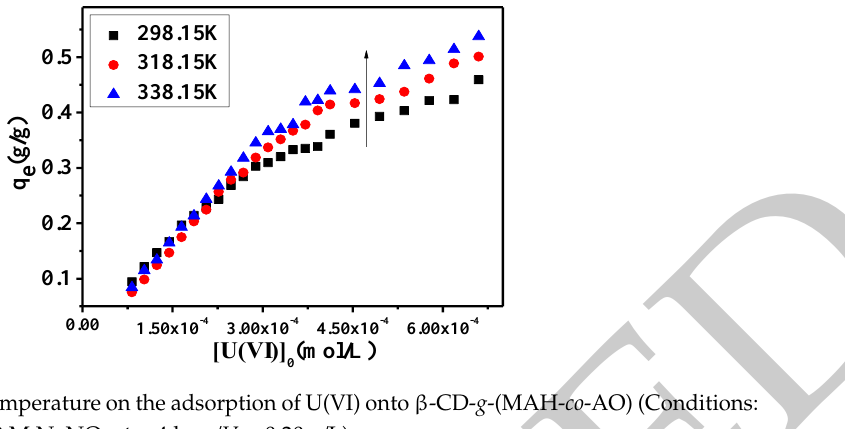
Table 5. Thermodynamic parameters.